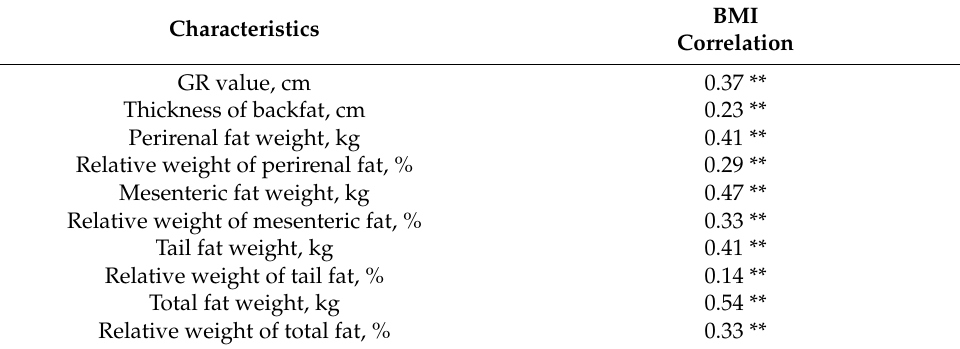
Table 1. Correlation analysis between BMI and fat deposition traits in sheep.